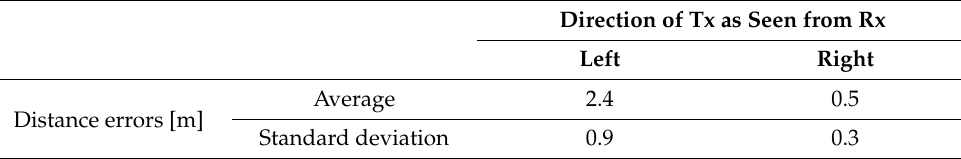
Table 2. Position estimation error results of the measurement simulation in the case of Tx moving on a T-shape road.